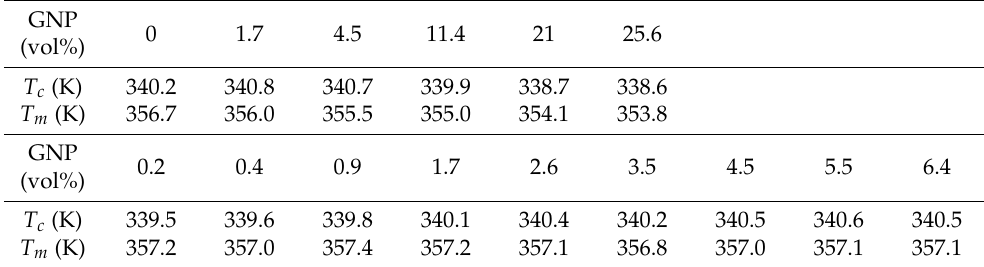
Table 4. Melting ( T m ) and crystallisation ( T c ) temperatures for the various compositions of EVA20 as a function of filler loading as observed by DSC.